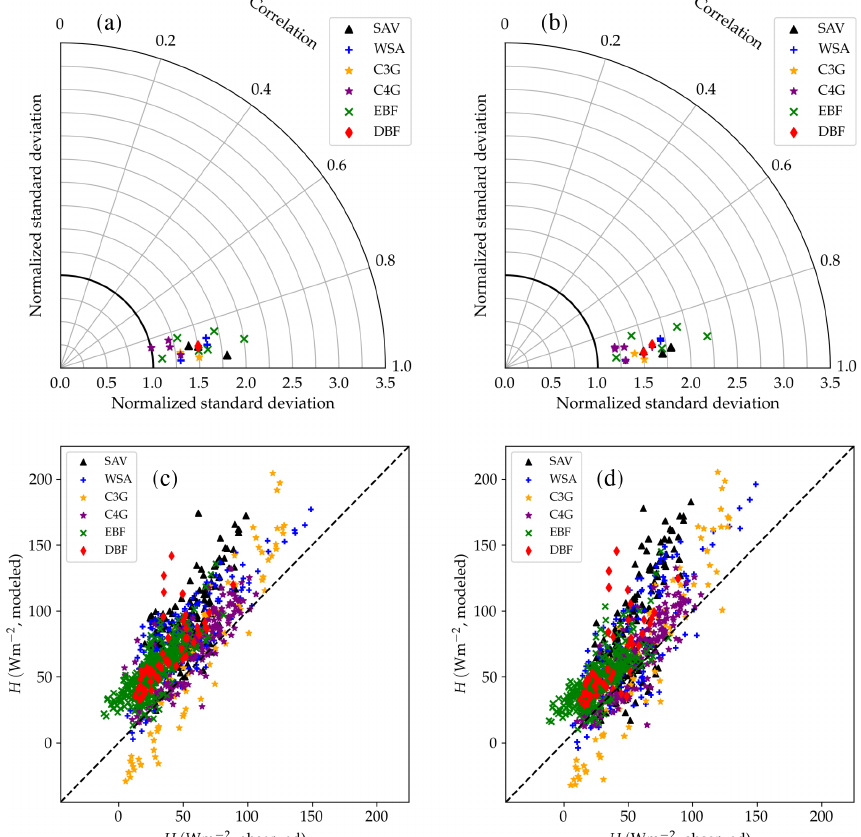
Figure 13. Performance of the CLM/BB (a, c) and CLM/Med (b, d) runs for sensible heat flux. The Taylor diagrams (Taylor, 2001) in panels (a) and (b) summarize the degree of agreement between observed and simulated hourly fluxes by relying on the geometrical relationship between the “centred pattern” root mean square difference (defined as E (cid:48) 2 = RMSE 2 − Bias 2 ), the correlation coefficient, and the standard deviation of observed and modelled data: E (cid:48) 2 = σ 2 o + σ 2 m − 2 σ o σ m r . Each point in the polar diagram represents a simulation. The radial coordinate indicates the ratio between modelled and observed standard deviations. The correlation between observed and modelled values is encoded by the polar angle; it decreases anticlockwise from r = 1 (perfect correlation) for points situated on the x axis to r = 0 for points situated on the y axis. The distance between a point in the diagram and the reference value 1 on the x axis equals the centred pattern RMSE normalized by the standard deviation of the observed values, E (cid:48) /σ o , and is therefore a measure of the agreement between observed and simulated data. The scatter plots ( panels c, d) show a direct comparison of observed and modelled monthly-averaged fluxes. The different symbols refer to different land cover types: savanna (SAV), woody savanna (WSA), C 3 grasslands (C3G), C 4 grasslands (C4G), evergreen broadleaf forest (EBF), and deciduous broadleaf forest